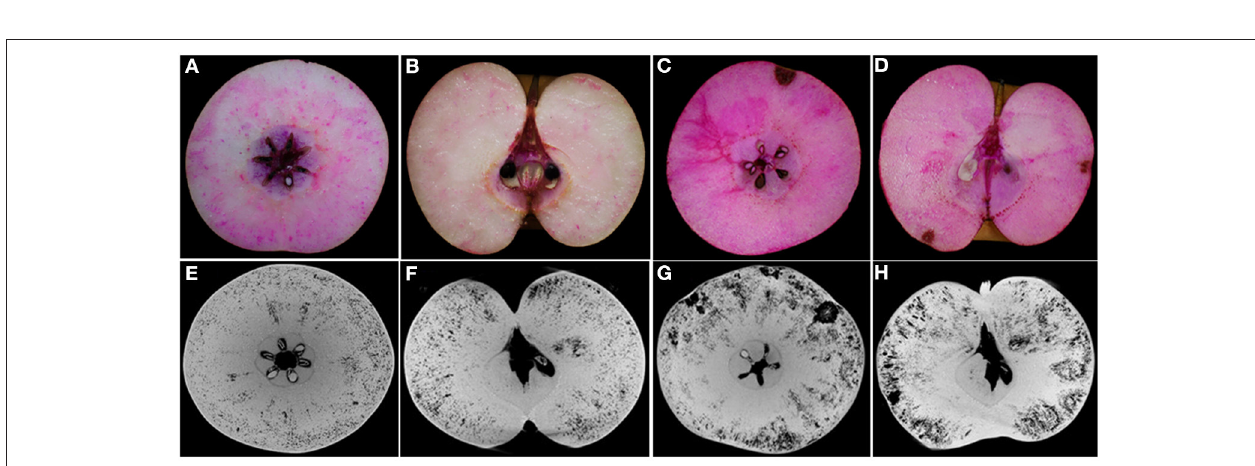
FIGURE 1 | Comparison of the appearance of healthy and cork spotted “Akizuki” fruit at harvesttime. (A) Healthy fruit. (B,C) Gray and yellow rendering of healthy fruit with X-ray scanning, respectively. (D) Cork spotted fruit. (E,F) Gray and yellow rendering of cork spotted fruit with X-ray scanning, respectively.